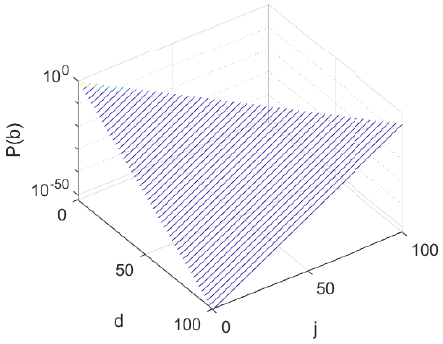
Figure 3. Evolution of probabilities with d and k . Note the logarithmic scale on the Z